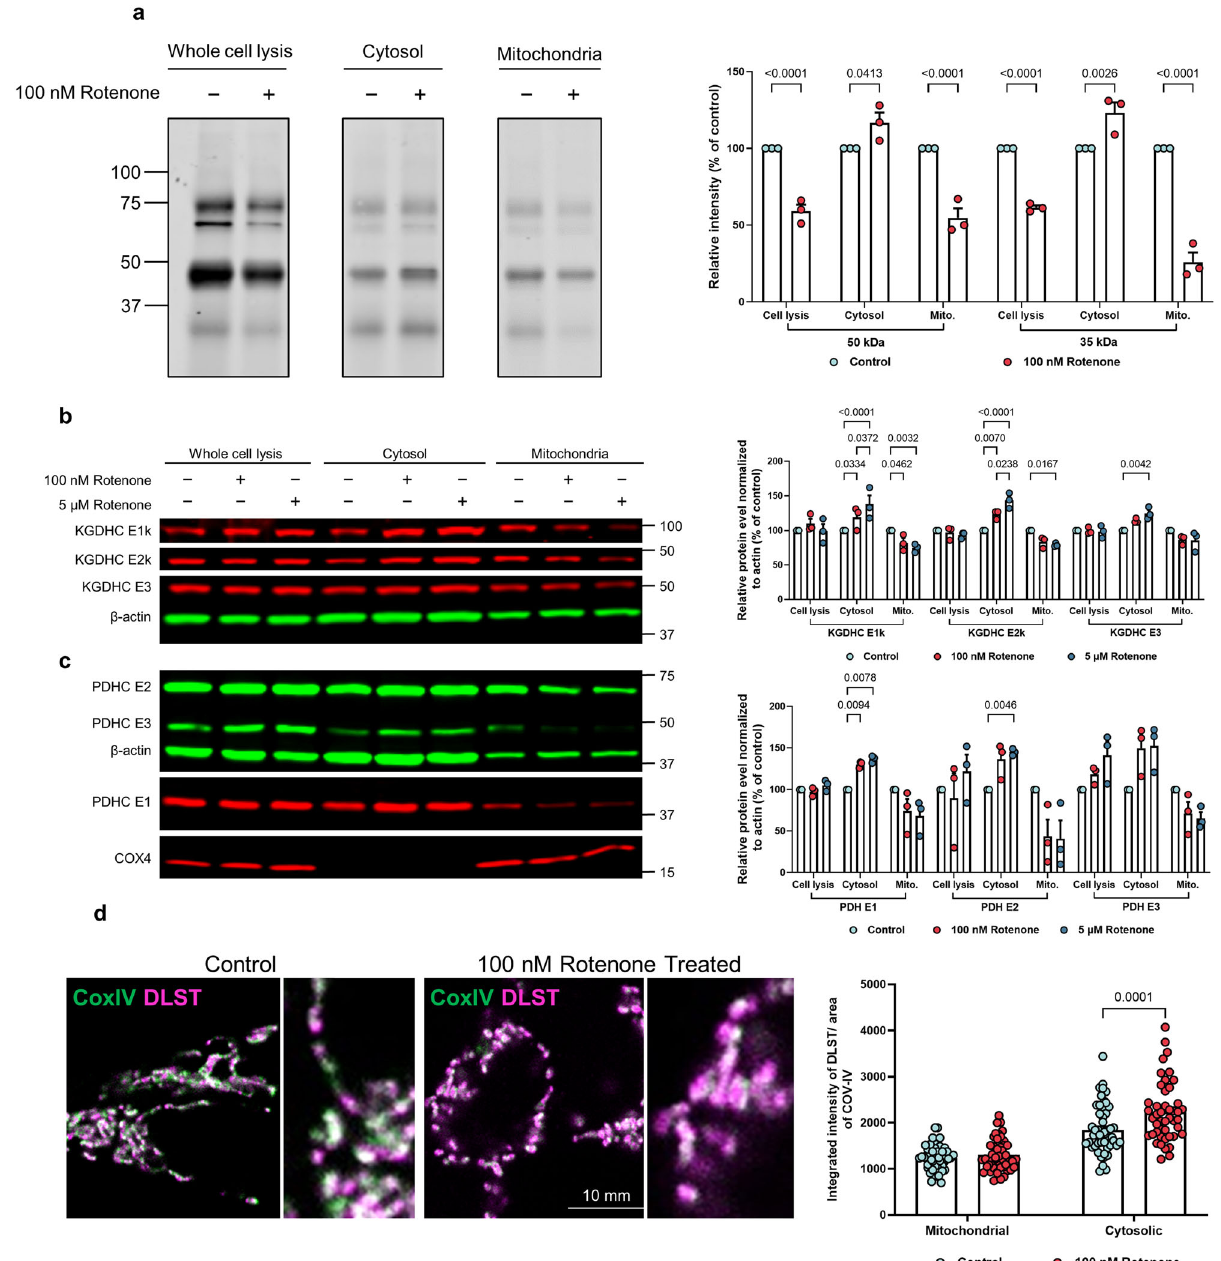
Fig. 4 Impairing mitochondrial function altered succinylation and protein distribution in the whole cell as well as in the mitochondria and non- mitochondrial fractions. a The effects of rotenone (100 nM/20 min) on succinylation in HEK cells. After separation, mitochondrial and non-mitochondrial fractions were immune-precipitated with anti-succinyl lysine antibody and separated by SDS-PAGE followed by western blotting. The data from three different replicate experiments were expressed as the mean with error bars from standard error of the mean (SEM) ( n = 3 independent experiments, two- way ANOVA followed by Bonferroni ’ s multiple comparisons test). b The effects of rotenone (100 nM or 5 μ M/20 min) on the distribution of KGDHC protein between mitochondria and non-mitochondrial fractions. The data from three different replicate experiments were expressed as the mean with error bars from SEM ( n = 3 independent experiments, two-way ANOVA followed by Tukey ’ s multiple comparisons test). c The effects of rotenone (100 nM, 5 μ M/20 min) on the distribution of PDHC protein between mitochondria and non-mitochondrial fractions. The data from three different replicate experiments were expressed as the mean with error bars from SEM ( n = 3 independent experiments, two-way ANOVA followed by Tukey ’ s multiple comparisons test). d Rotenone induces release of DLST into cytoplasm. In the control conditions, DLST (magenta) was concentrated inside mitochondria de fi ned by COX-IV labeling (green). After 1 h of 100 nM Rotenone treatment, additional DLST labeling was found in the cytoplasm. Inserts on the right are magni fi ed regions. Magenta: DLST; Green: COX-IV; Error bars represent SEM deviation from the mean ( n = 98 fi elds from 19 dishes, two-way ANOVA followed by Bonferroni ’ s multiple comparisons test). Source data are provided as a Source Data fi